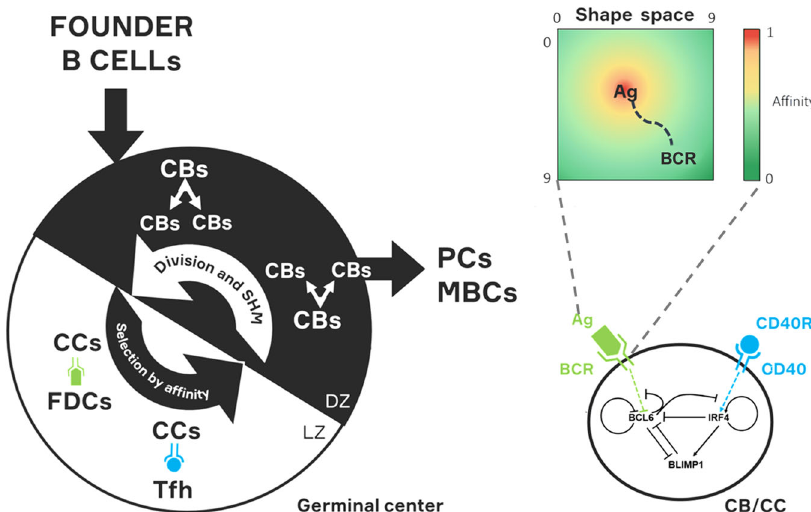
Fig. 1 General scheme of our single-GC eMS model. Founder B cells enter the GC and go through a process of division and SHM in the DZ and selection in the LZ, based on the af fi nity of their BcRs. Each B cell (CB/CC) represented by the ABM embeds a GRN that is affected by BcR and CD40 signaling to drive PC differentiation. The af fi nity of BcRs can assume values between 0 and 1 and is based on an abstract shape